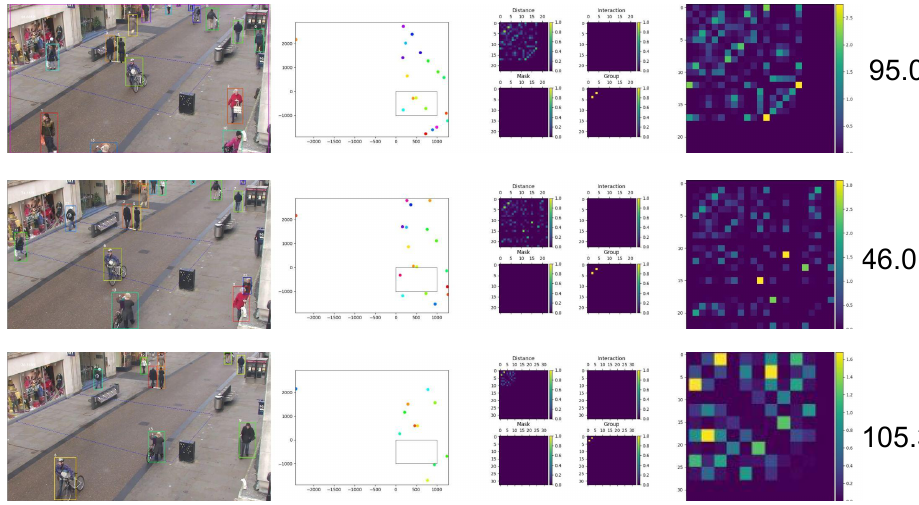
Figure 13. Full system result of oxford